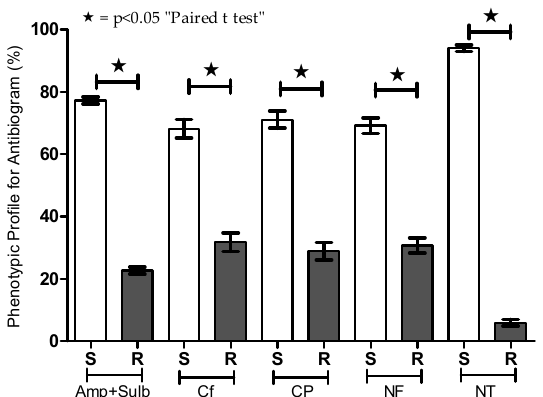
Figure 2. Phenotypic profile for susceptibility testing (antibiogram) of urine cultures positive for E. coli from outpatients. Antibiotics including ampicillin + sulbactam (Amp + Sulb), cephalothin (CF), ciprofloxacin (CP), norfloxacin (NF), and nitrofurantoin (NT) were tested by the disc diffusion method. Percentages of sensitive (S) and resistant (R) strains are presented. * p < 0.05.